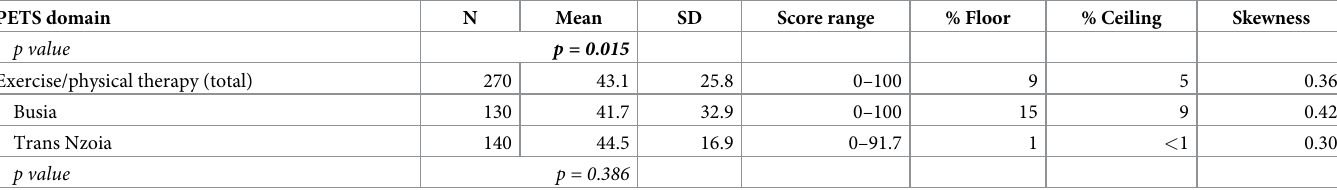
Fig 2 disaggregates PETS scores for the total sample by number of chronic conditions. Per- haps somewhat counterintuitively, we found higher scores for people reporting one chronic condition compared to those with two or more conditions in several domains although differ- ences were not statistically significant. The only domains where burden scores were signifi- cantly higher with more chronic conditions were role/social activity limitations and